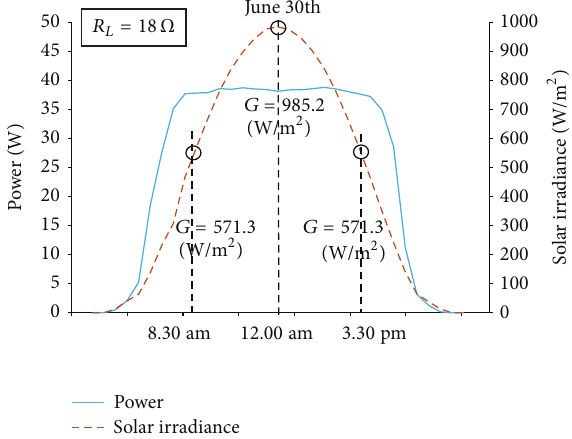
Figure 5: Power production of a PV panel with an electrical load 𝑅 𝐿 = 18 Ω